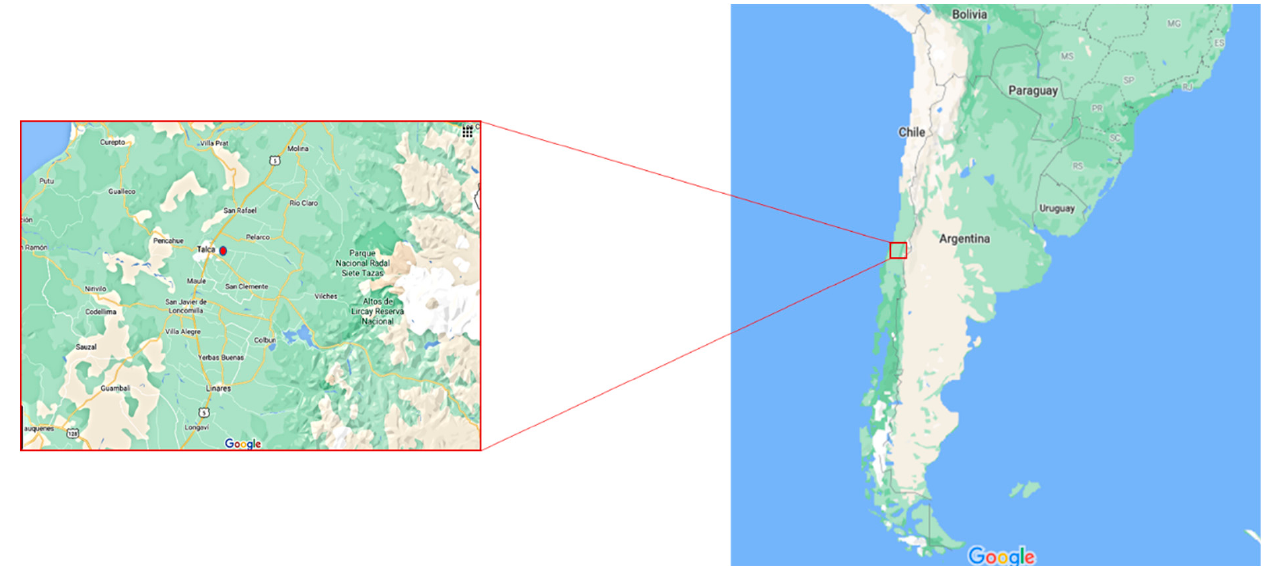
Figure 1. Location of the vineyard samples from which grapes were